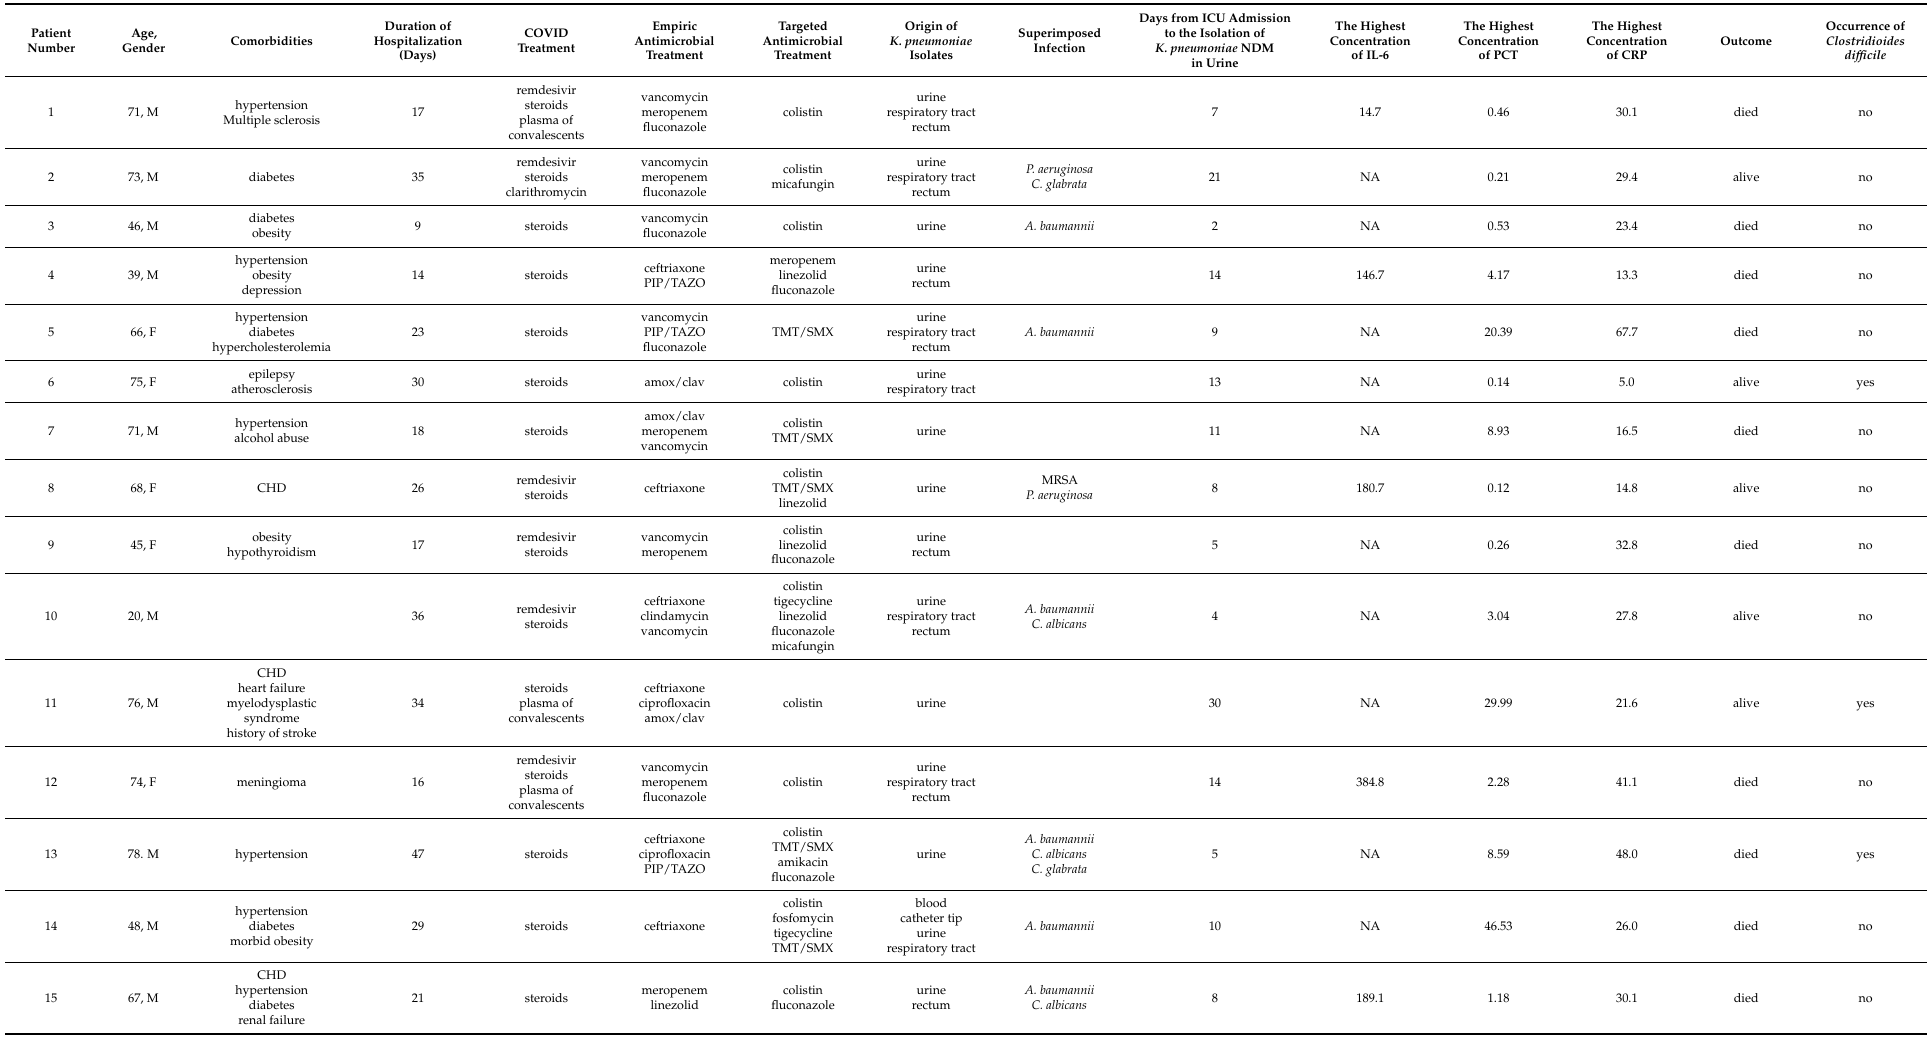
Table 1. The cohort of patients with COVID-19 and isolates causing secondary CPE